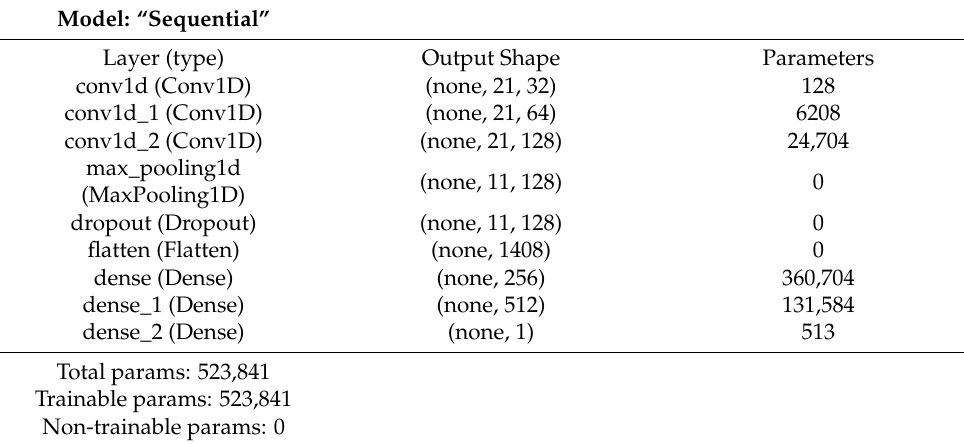
Table 6. Architecture of the custom 1D-CNN classifier.